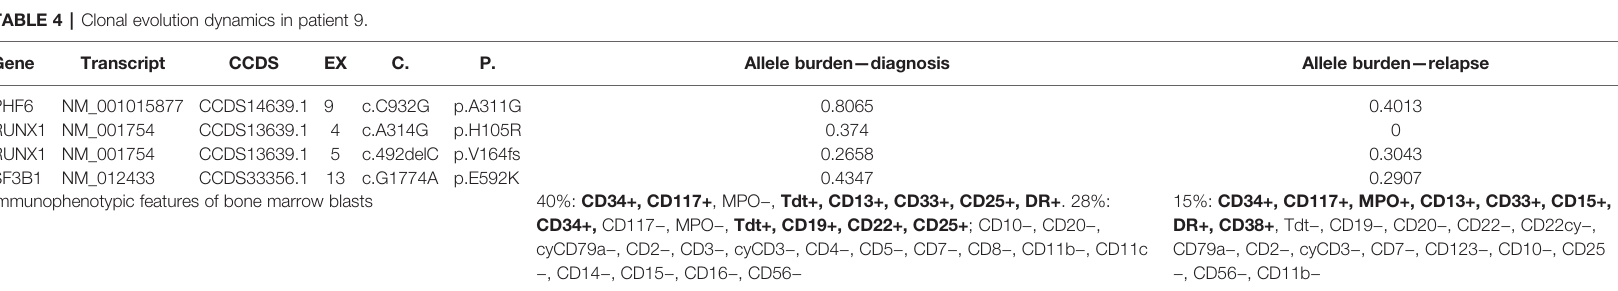
TABLE 4 | Clonal evolution dynamics in patient